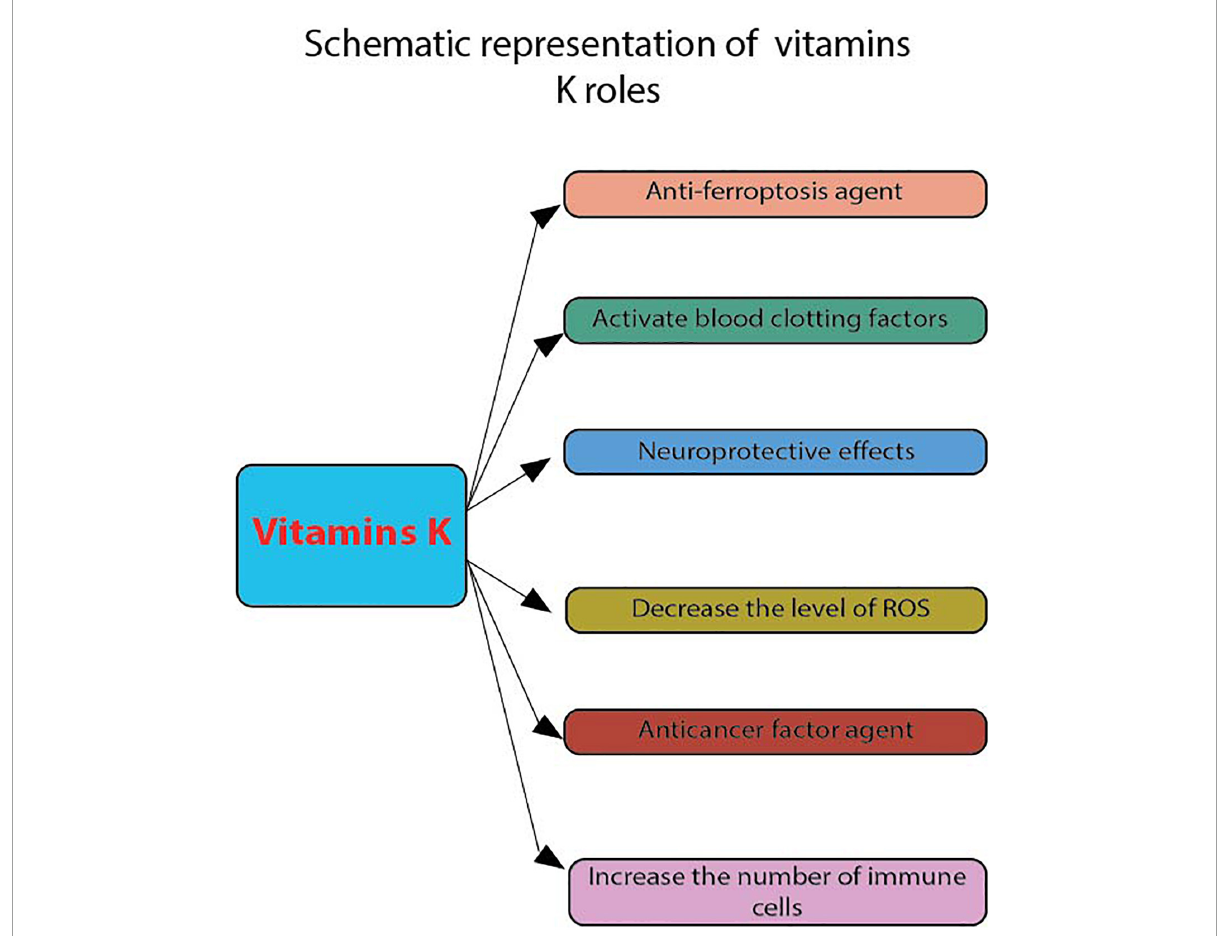
FIGURE2 Schematic representation of vitamins K roles. These were evaluated by flow cytometry: anti-ferroptosis agent, activate blood clotting factors, neuroprotective effects, decrease the level of ROS, anticancer factor agent and increase the number of apoptotic